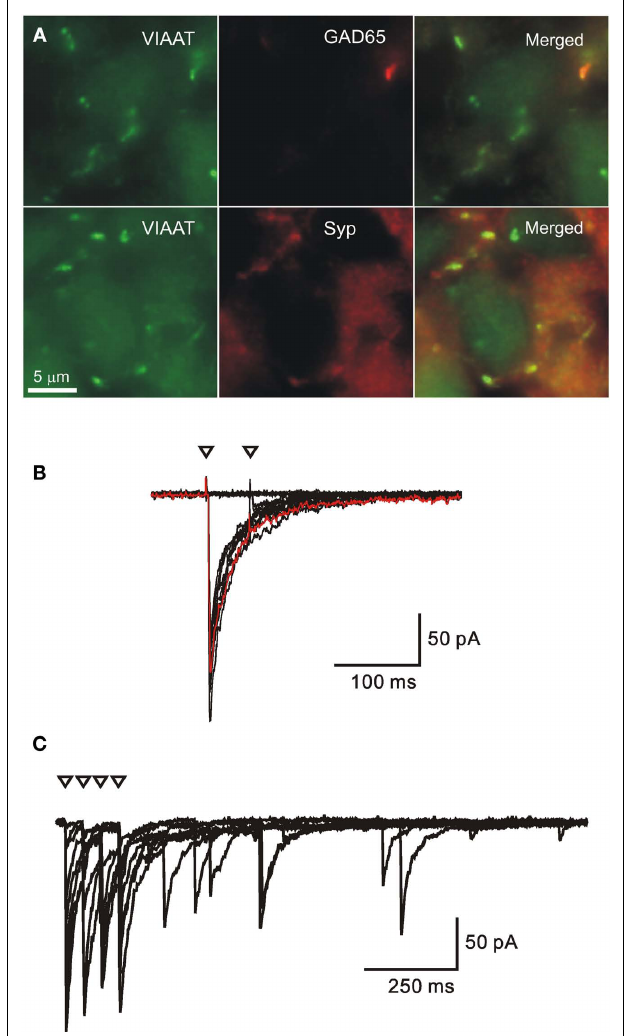
FIGURE 1 | Early onset of GABAergic synaptic transmission and synapse formation in the embryonic superior colliculus (E17). (A) Specimens from sections of the immunostained superior colliculus. Most GABAergic synaptic terminals are double-immunoreactive for the vesicular inhibitory amino acid transporter (VIAAT) and synaptophysin (Syp) but few of them already stain for GAD65. (B,C) Electrophysiological recording of unitary synaptic responses in acute slices from the E17 mouse superior colliculus. Minimal stimulation with two (B) and four (C) pulses at an interval of 50ms.Triangles denote time of stimulation. Note absence of second eIPSC in A and asynchronous delayed IPSCs in (B) . (Modified from (Grantyn et al.,